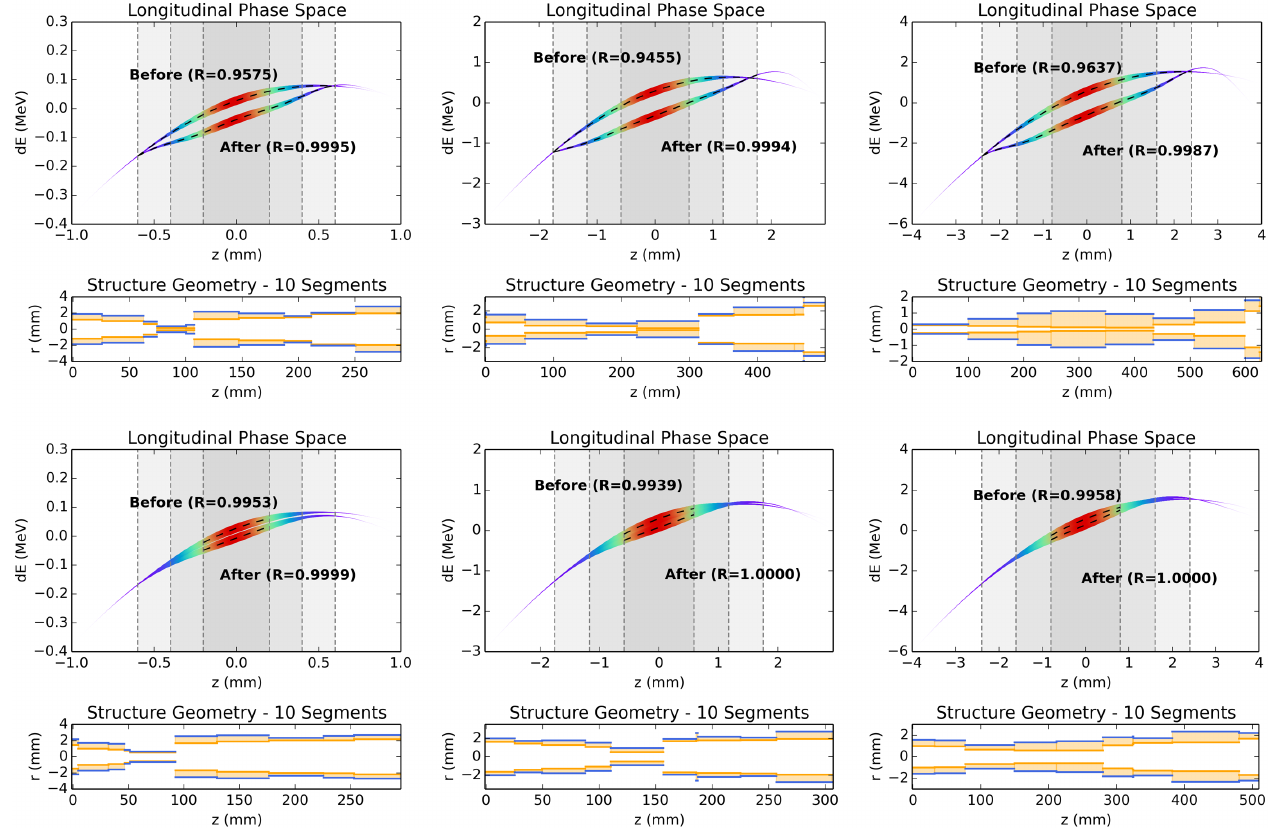
FIG. 8. LPSS optimization results for input LPSs based on the ARES working points shown in Table II. The optimization goal was to achieve R ¼ 1 across the full 6 σ ROI (top row), as well as a centered 2 σ ROI (bottom row). From left to right: WP1, WP2, WP3. Each plot shows the LPS before and after the LPSS interaction. The color and thickness visualize the current profile. The gray shaded areas correspond to the 2, 4 and 6 σ regions respectively. The head of the bunch is on the left (negative z values). Below the main plot, the geometry of the final segmented DLW is visualized, with the orange line corresponding to the inner radius and the blue line to the outer